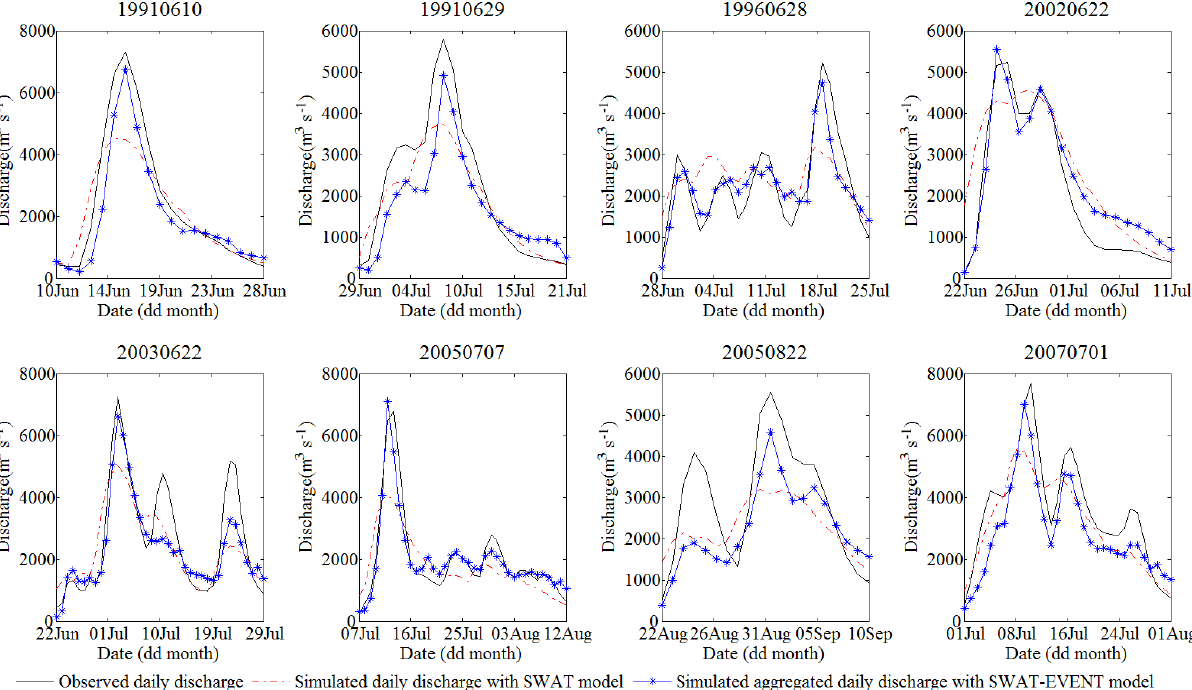
Figure 8. Comparisons of the daily simulations conducted using the SWAT model and the aggregated sub-daily simulations conducted using the SWAT-EVENT model.